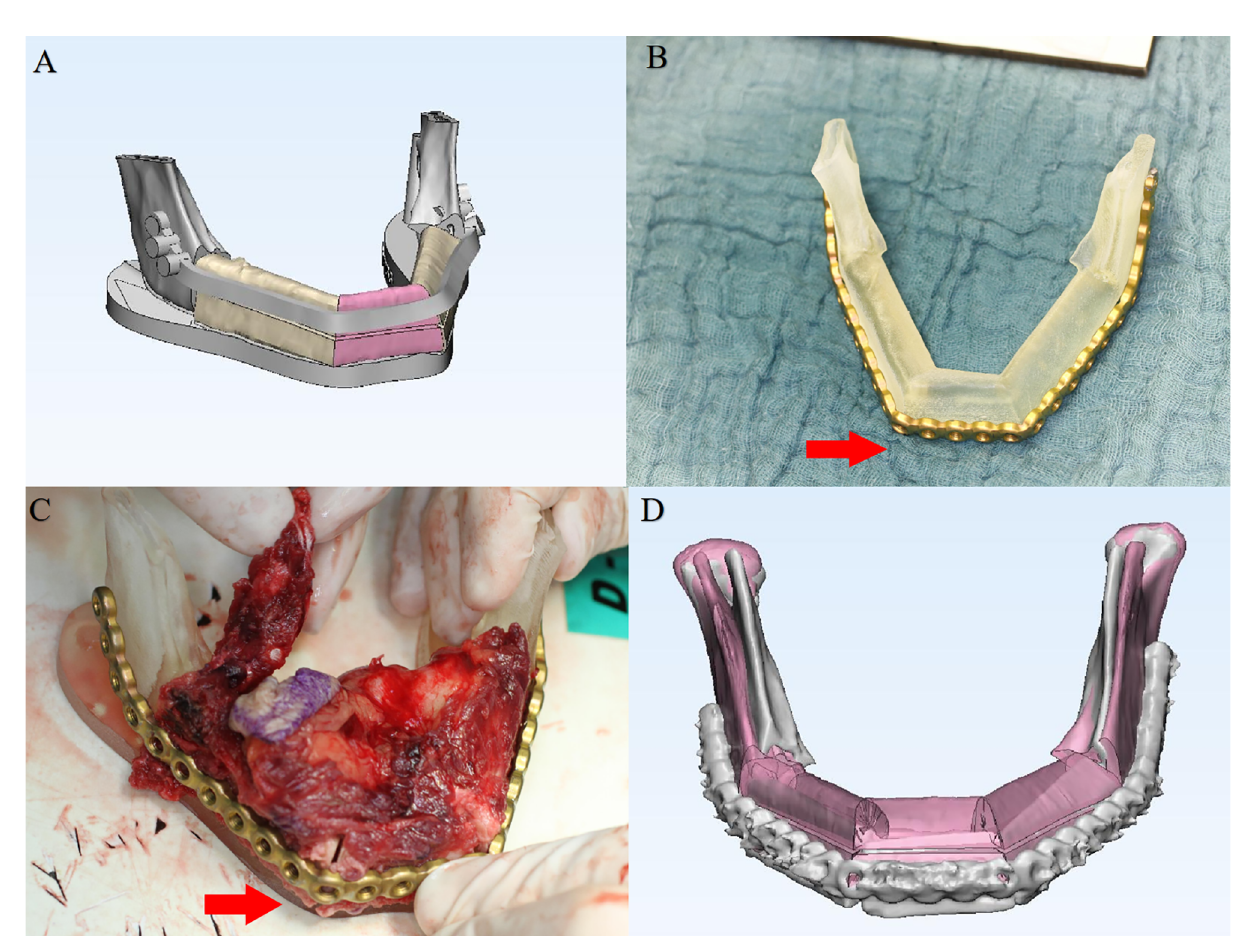
FIGURE 4 | A 56-year-old patient with mandibular squamous cell carcinoma showing partial computer-assisted surgical compliance. (A) Virtual surgical planning for mandibular reconstruction. (B) Plate prebending on the 3D printed model. (C) Intra-operative plate bending modi fi ed due to un fi tness. (D) Postoperative superimposition verifying the 3-D deviation of the reconstructed region compared with the original virtual surgical